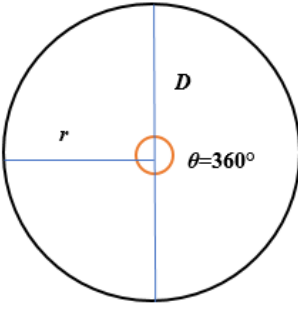
Figure 6. The line to circle conversion.